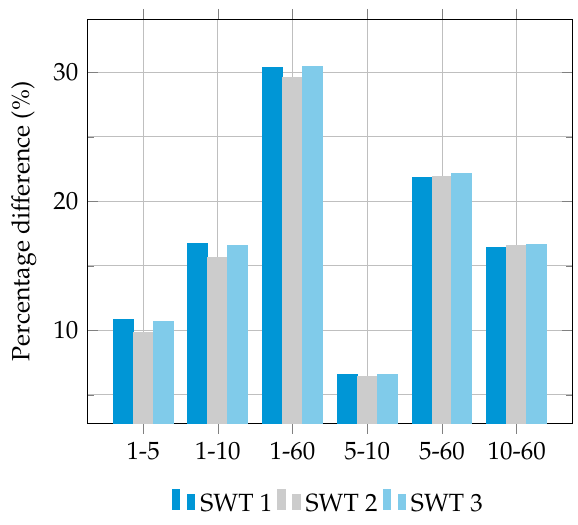
Figure 6. Wind power production was calculated for three (SWTs) and time series using mean times of 1, 5, 10, and 60 min. Then, the difference between resource assessments was calculated for different mean times. The 1-5 label represents the difference between the 1- and 5-min assessments, and so on for the remainder of the time series. It is observed that the percentage depends mainly on mean times, but the differences due to the SWT model are not significant. The largest percentage difference is approximately 30% and corresponds to the 1- and 60-min assessments.